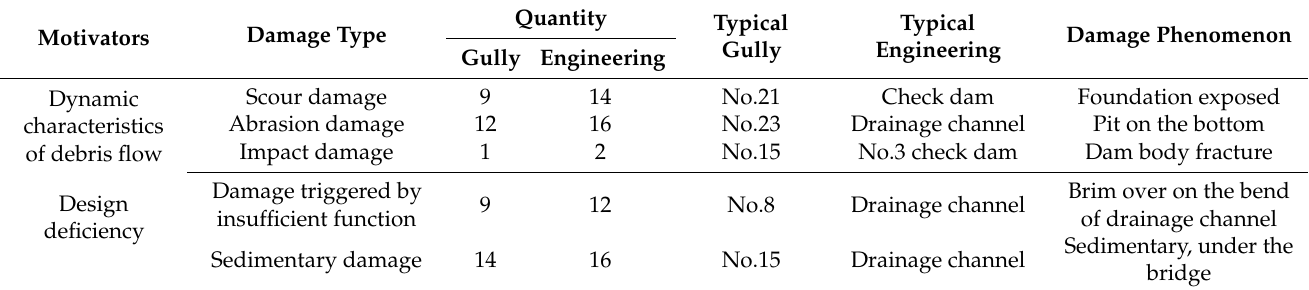
Table 3. Statistics of damage type of mitigation engineering of glacial debris